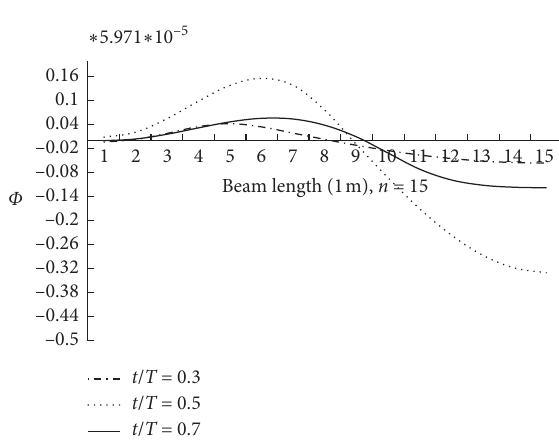
Figure 16: C-S T Beam (1) cross-section rotation.